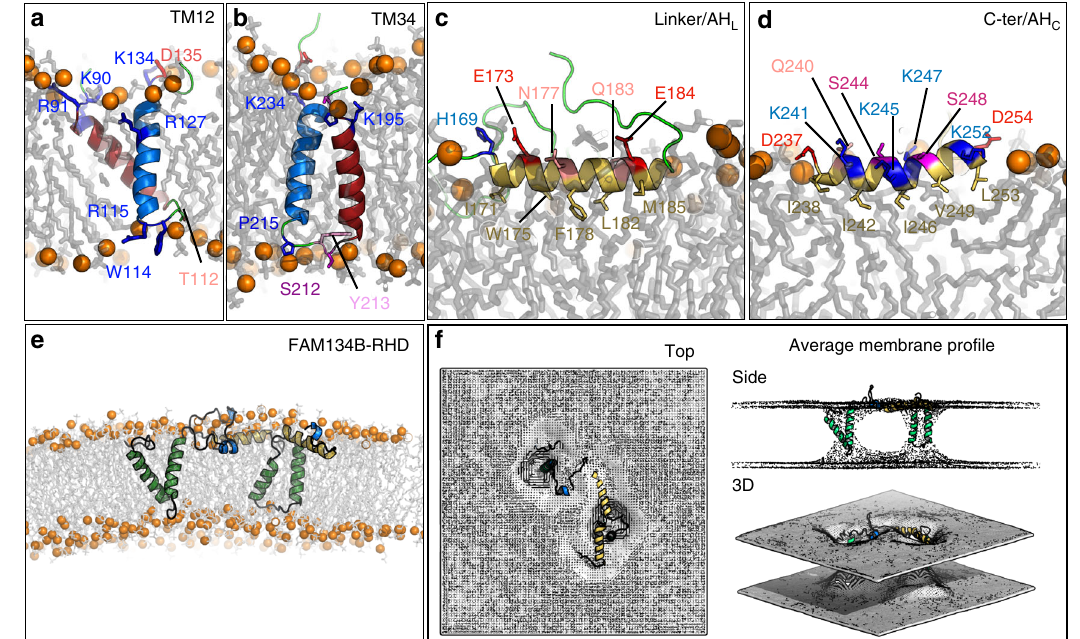
Fig. 2 3D structural model of FAM134B-RHD from MD simulations. a , b Transmembrane fragments fold into helical hairpins (red and blue helices in ( a ) TM12 and ( b ) TM34. Flanking charged and polar residues and luminal loop residues anchor the two hairpins within the ER membrane (labeled side chains). c , d Linker and C-terminal fragments form amphipathic helices ( c ) AH L and ( d ) AH C (yellow cartoon). Polar (colored labels) and apolar residues (yellow labels) on opposite sides position the helices at the water – bilayer interface. e Overlapping, individually re fi ned fragment structures were used to assemble the FAM134B-RHD (80 – 260) structural model. The model was fi rst equilibrated using coarse-grained simulations and then re fi ned with all-atom MD simulations. f Time-averaged local membrane pro fi le (gray mesh; top, side, and 3D views) around FAM134B-RHD (colored) computed from all-atom